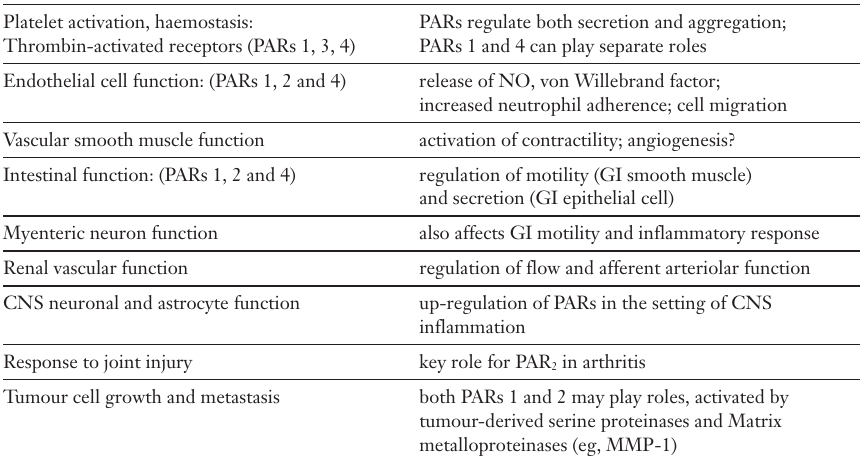
Potential physiologi- cal roles for